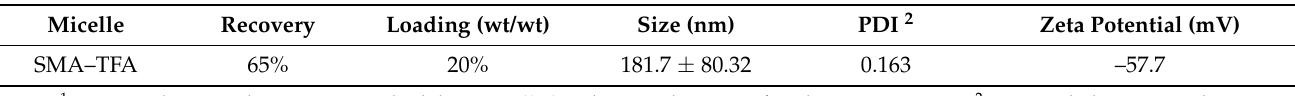
Figure 2. ( a ) Size distribution of SMA – TFA micelles. The size distribution of SMA – TFA micelles was determined using a Malvern Zeta Sizer at a concentration of 1.5 mg/mL in water. Data are expressed as the mean ± SEM ( n = 3); ( b ) SMA – TFA drug release studies. Cumulative release of TFA from SMA – TFA micelles at pH 7.4 in PBS. Data are presented as the average ± SD ( n = 3). Table 1. Characterization of SMA–TFA 1